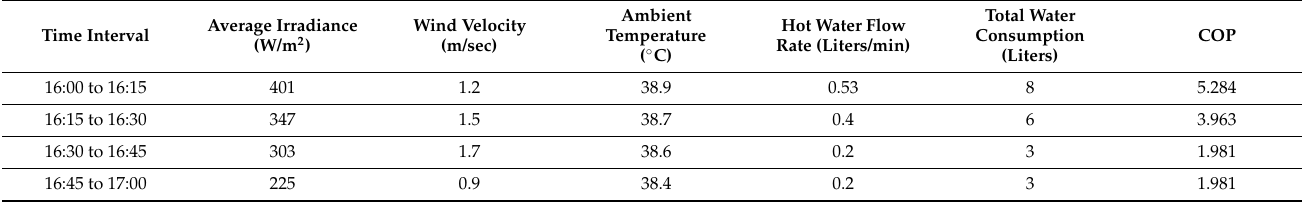
Table 7. Total water consumption—20 L (Electricity consumption—0.2